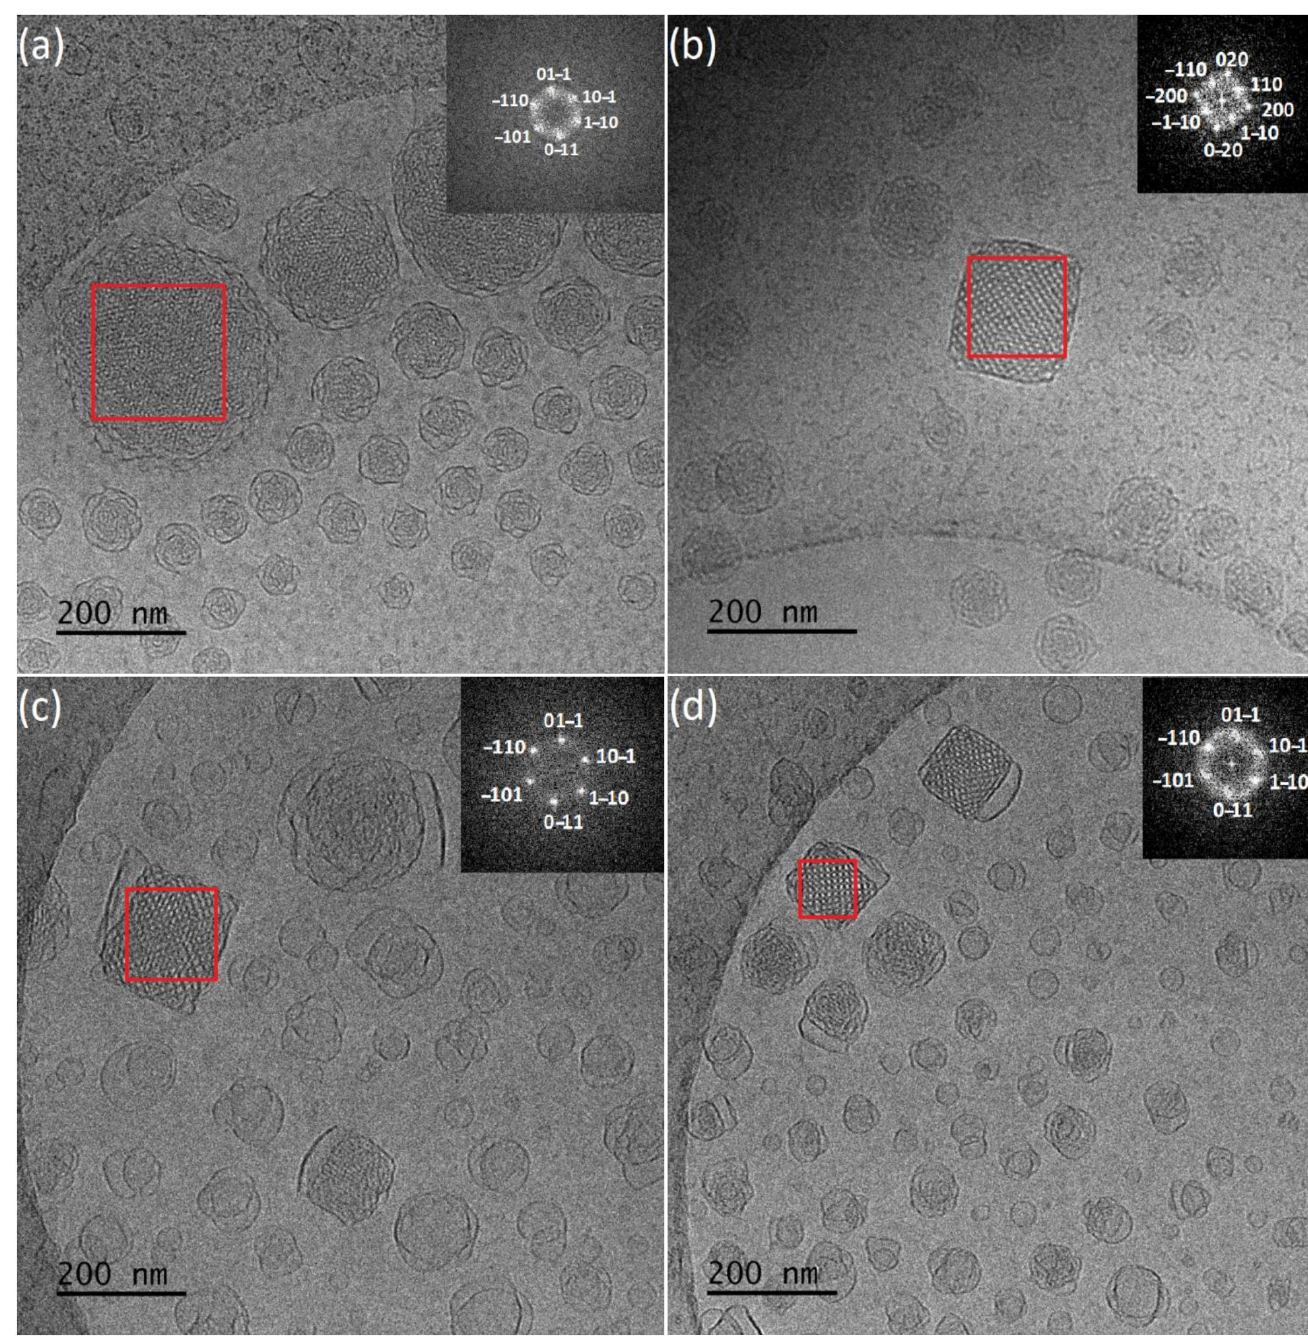
Figure 3. Fast Fourier transform analysis of particles with ordered internal structure for ( a ) GMO:PEO- b -PLA 9:1, ( b ) GMO:PEO- b -PLA 4:1, ( c ) GMO:PEO- b -PMEC 9:1, and ( d ) GMO:PEO- b -PMEC